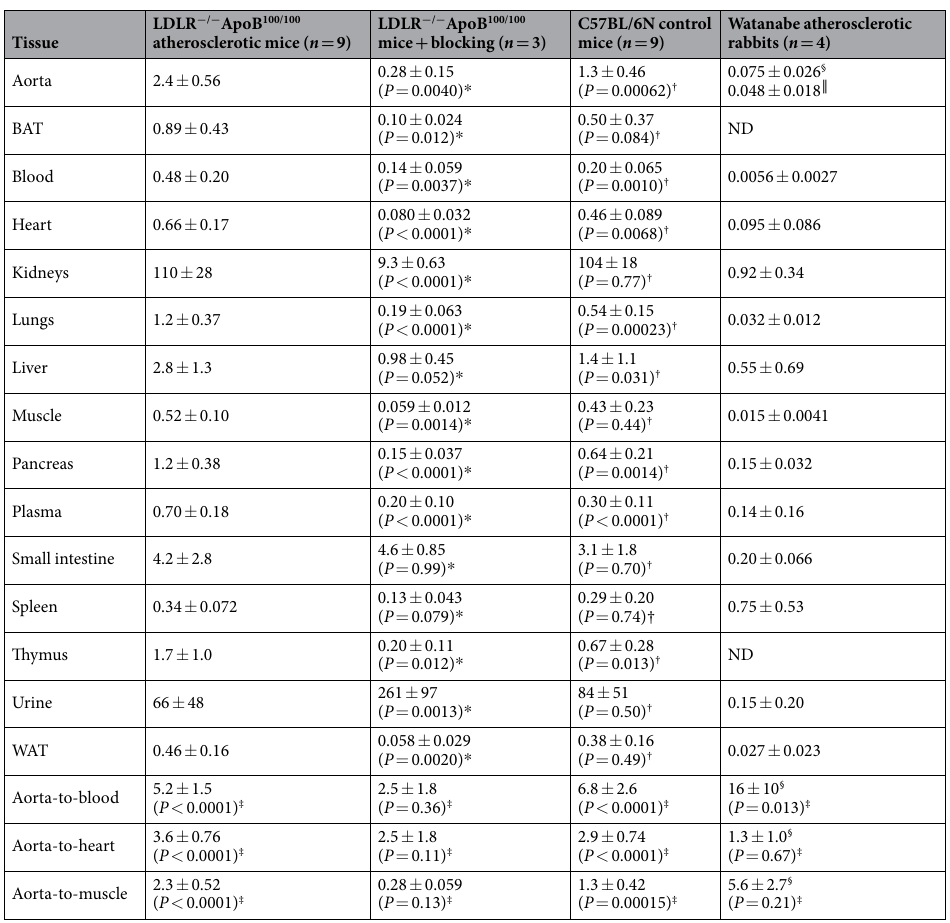
Table 2. Ex vivo biodistribution of 18 F-FOL in mice and rabbits. Results are expressed as a percentage of injected radioactivity dose per gram of tissue (mean ± SD with two significant figures) and obtained at 120 min post-injection. The blocking study was performed by injecting a 100-fold molar excess of folate glucosamine 1 min previous to the 18 F-FOL injection. * Difference between LDLR − / − ApoB 100/100 atherosclerotic mice vs . atherosclerotic mice + blocking, as assessed by independent samples t -test. † Difference between LDLR − / − ApoB 100/100 atherosclerotic vs . C57BL/6N control mice as assessed by independent samples t -test. ‡ Intra-animal comparison assessed by paired t -test. § Aorta with advanced atherosclerosis. ║ Aorta with mild atherosclerosis. BAT = brown adipose tissue; WAT = white adipose tissue; ND = not